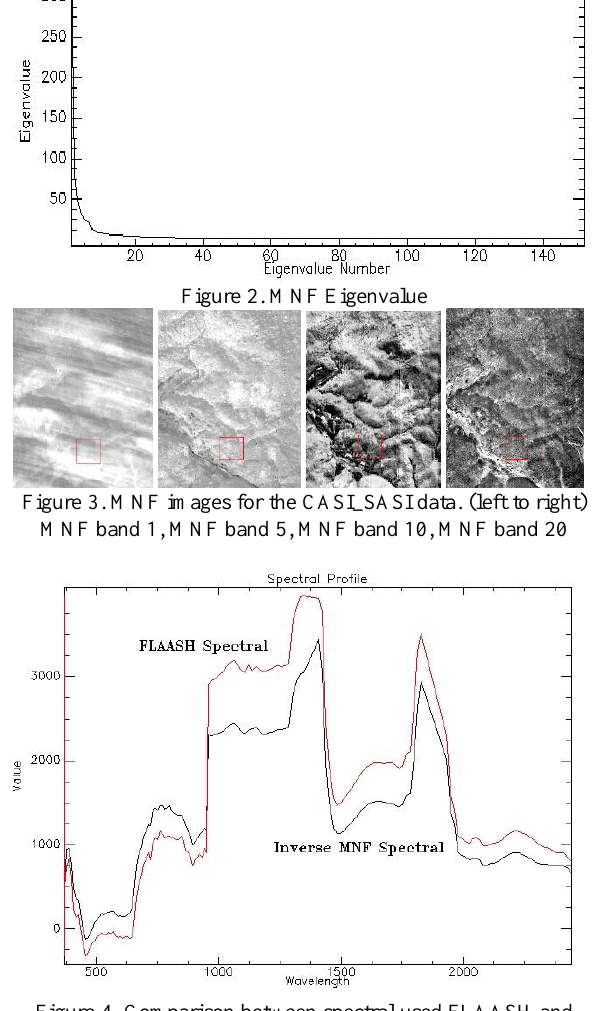
Figure 4. Comparison between spectral used FLAASH and spectral used Inverse MNF Figure 6. Field sample altered mineral map (magenta for calcite, white for chlorite, red for kaolinite, blue for muscovite, green for illite, cyan for phengite) To ensure the accuracy of the CASI_SASI data, its spectral absorption feature were extracted to compare to the field spectra (Figure 7). Figure 7 showed the rock spectra which included chlorite and muscovite alteration minerals, kaolinite and muscovite alteration minerals. This indicated that the CASI_SASI spectral feature was good matched with the field spectral